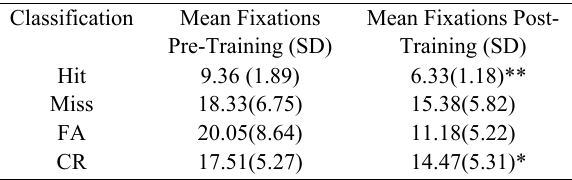
Table 2 – Mean number of fixations and standard deviations (SD) for the four classifications from user responses. The mean number of fixations per threat for the hits and CR were significantly different following training.